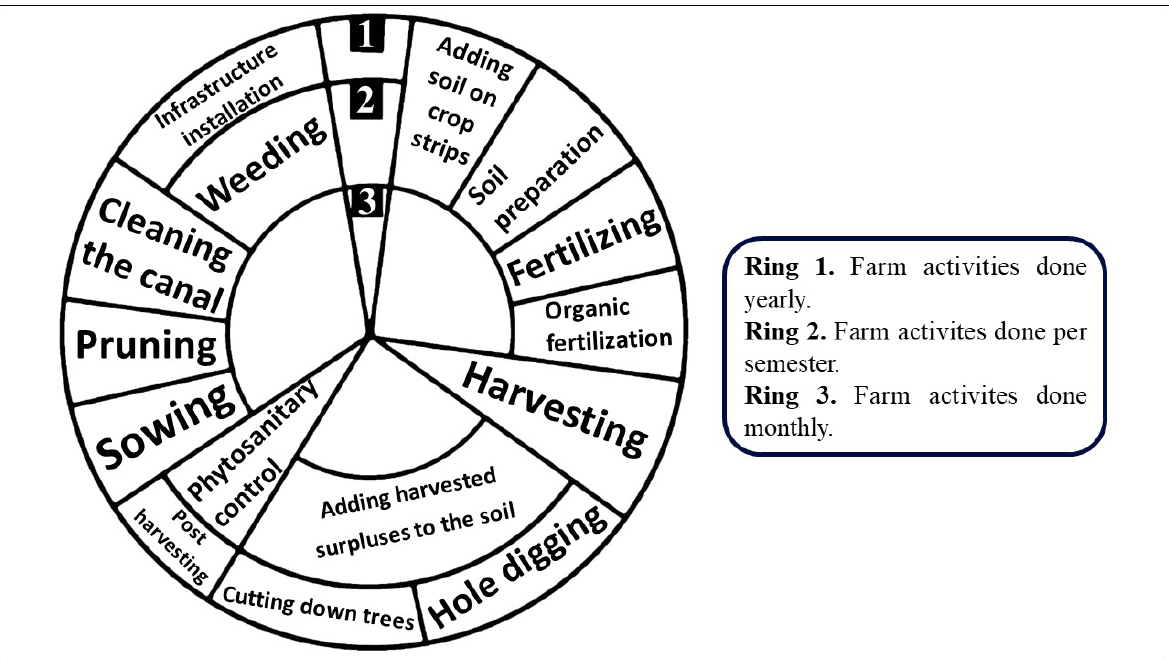
Figure 4. The most important labor activities and frequency of the management and maintenance of agrisilvicultural systems.